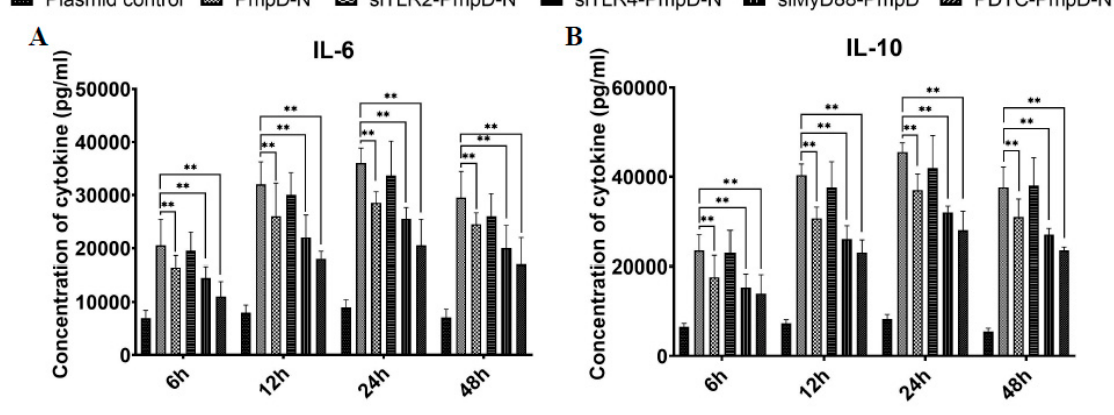
Figure 7. Effect of short interfering RNA (siRNA) or treatment with NF- κ B inhibitor on cytokine secretions in HD11 cells. HD11 cells were transfected with siRNA targeting TLR2, TLR4, and MyD88 or treated with the NF- κ B inhibitor pyrrolidine dithiocarbamate (PDTC) before stimulation with PmpD-N. Cell supernatants were collected and assayed for secretions of ( A ) IL-6 and ( B ) IL-10 using ELISA kits. Each experiment was repeated at least twice. Data are shown as the mean + SD values for triplicate cultures for one of two independent experiments. Statistically significant differences among different groups were evaluated with one-way analysis of variance (ANOVA) with Tukey’s post hoc multiple comparisons test and were considered to be statistically significant at ** p < 0.01.